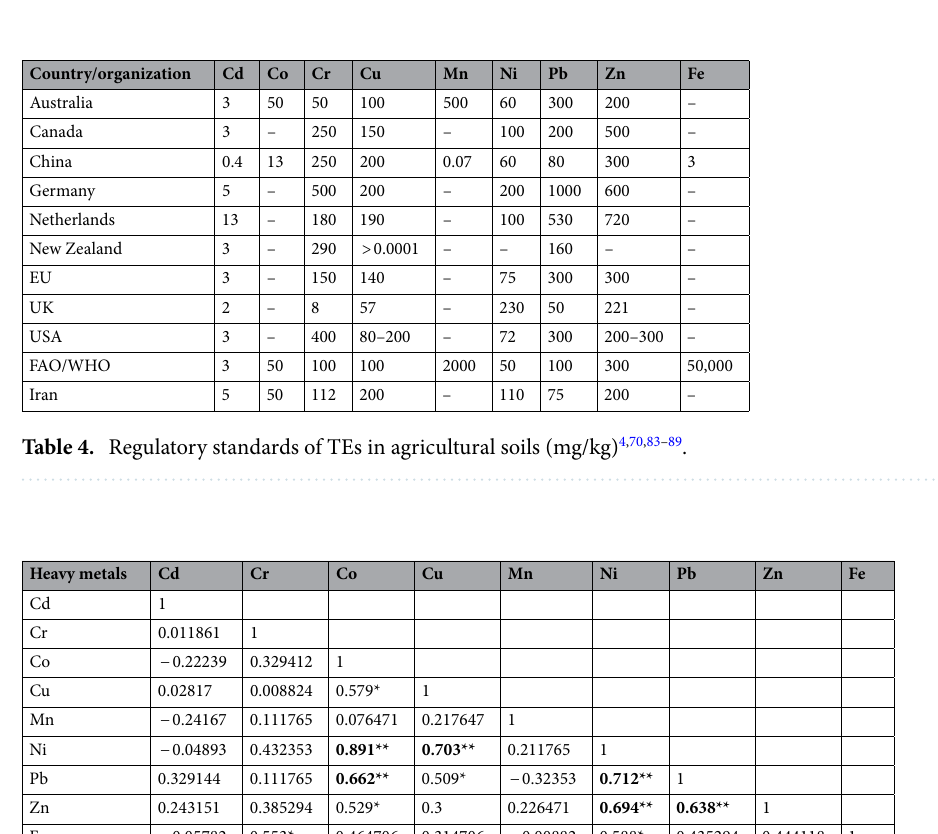
Table 3. Concentrations of TEs in the soils of farmlands (n = 3).